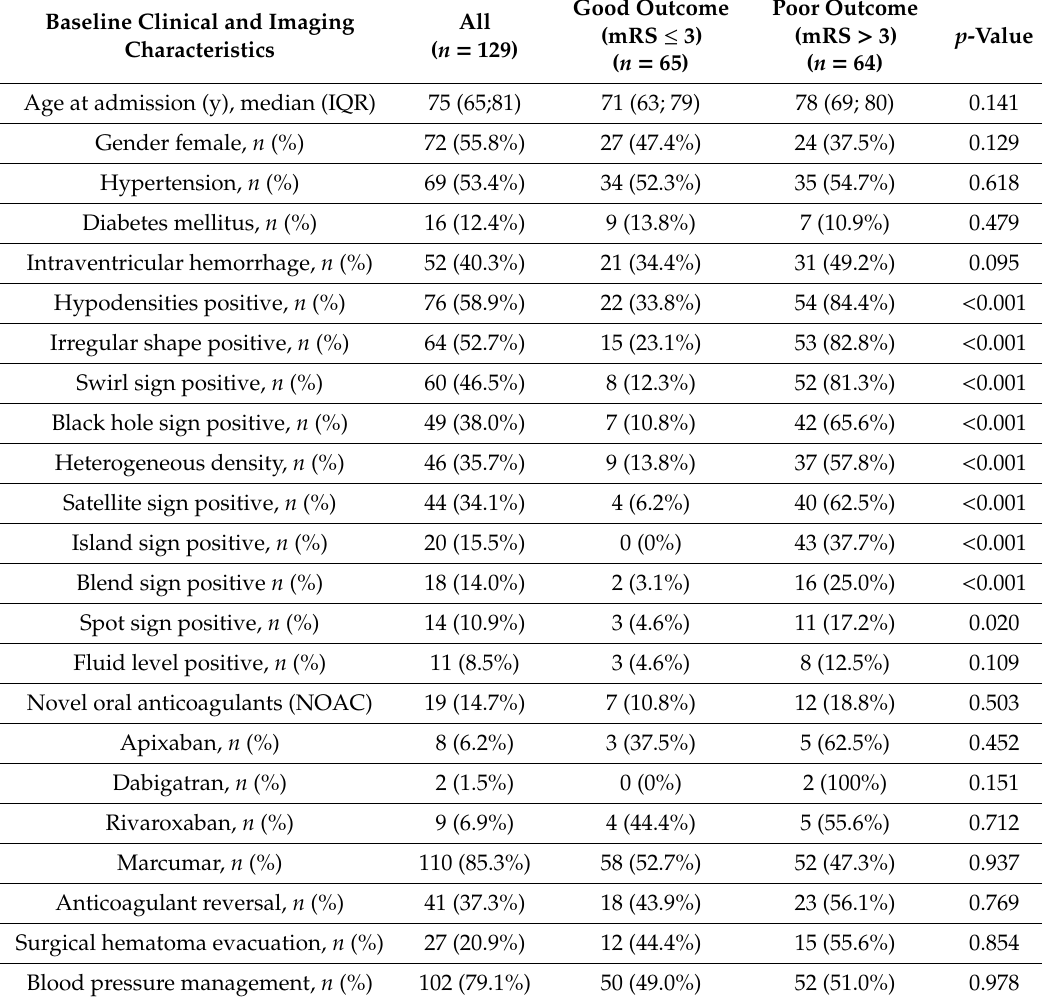
Table 1. Comparison of baseline demographic, clinical, and radiological characteristics between patients with and without poor outcome. IQR: interquartile range, mRS: modified Rankin Scale. Baseline Clinical and